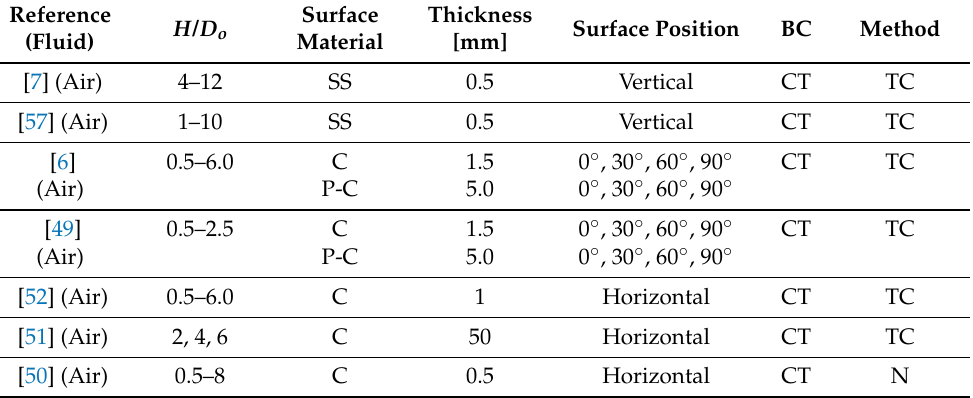
Table 5. Overview of literature publications on impinging coaxial jets: Heat transfer. “BC” (Boundary Condition): “TC” (Thermocouple), “CT” (Constant temperature); “SS” (Stainless steel), “C” (Copper), “P-C”